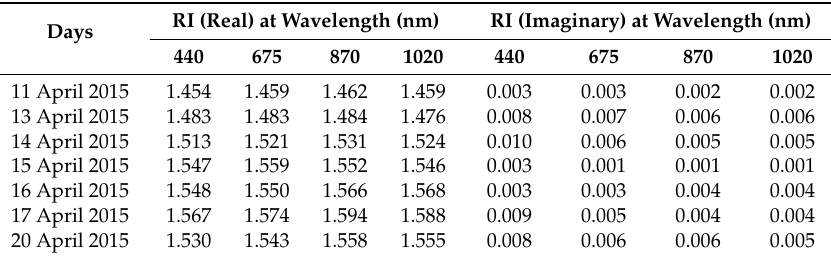
Table 3. Refractive index during dusty and non-dusty